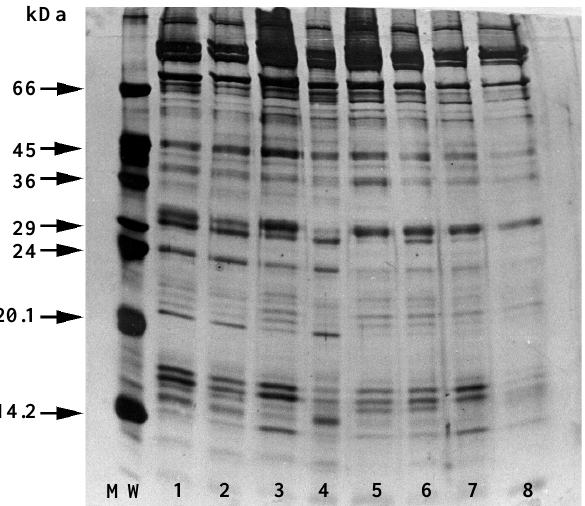
Figure 1 - Electrophoresis in 14% SDS-PAGE of membrane proteins of bovine spermatozoa. (MW) Standard of molecular mass SDS-6H. (1) Nelore, (2) Nelore, (3) Limousin, (4) Simmental, (5) Nelore, (6) Gir, (7) Holstein, and (8)